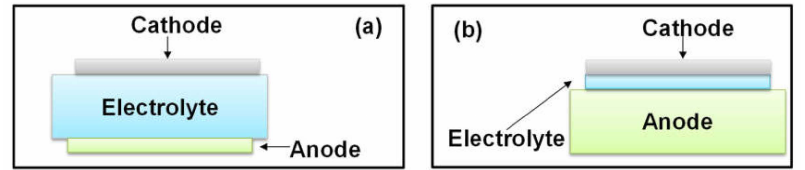
Figure 1. Schematic of most popular SOFC planar configurations: ( a ) ESC and ( b ) ASC.